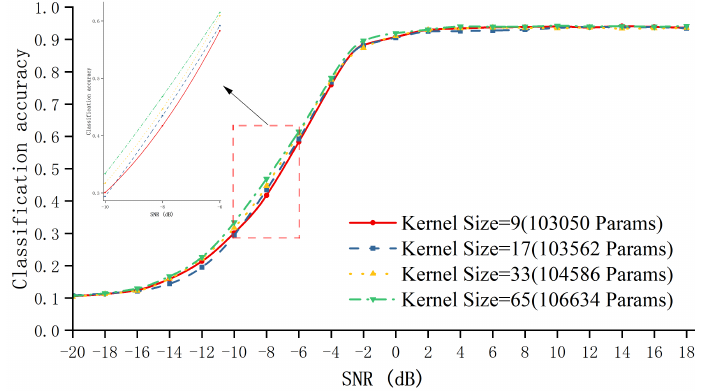
Figure 14. Classification accuracy vs. SNRs for TMRN-GLU with various number of Kernel Size.